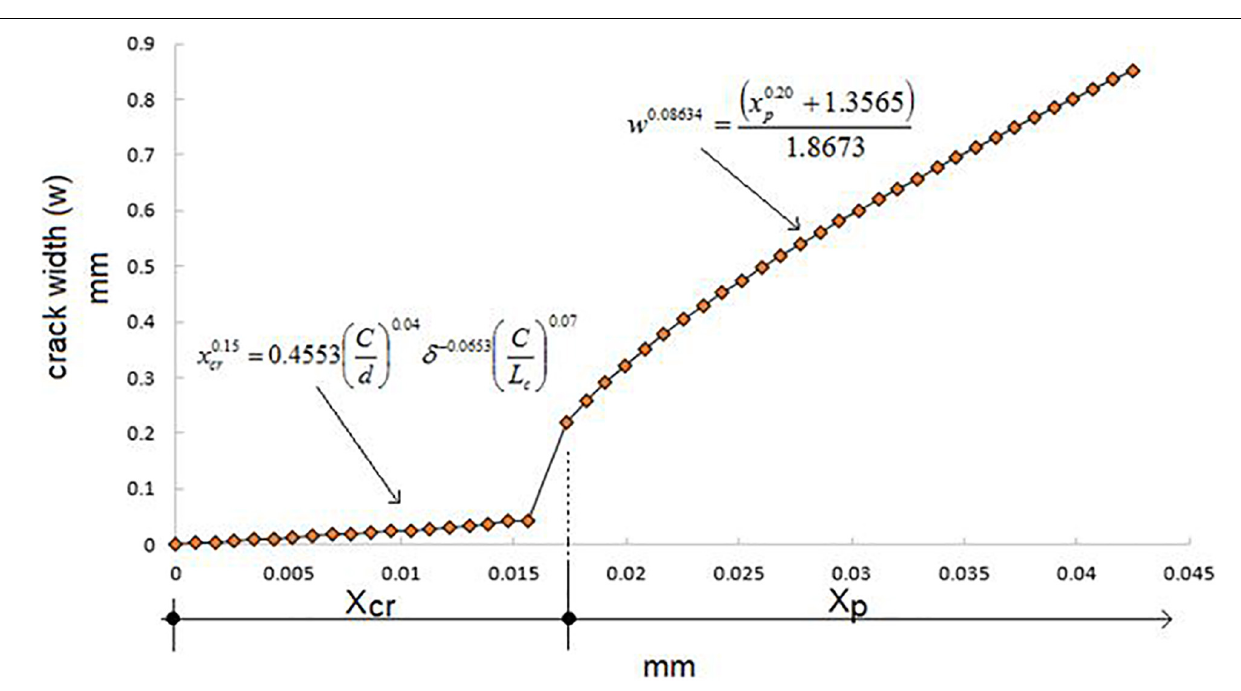
FIGURE 8 | Crack width analysis as a function of x cr (steel corroded cross-section when first crack observed) and x p (steel corroded cross-section after crack